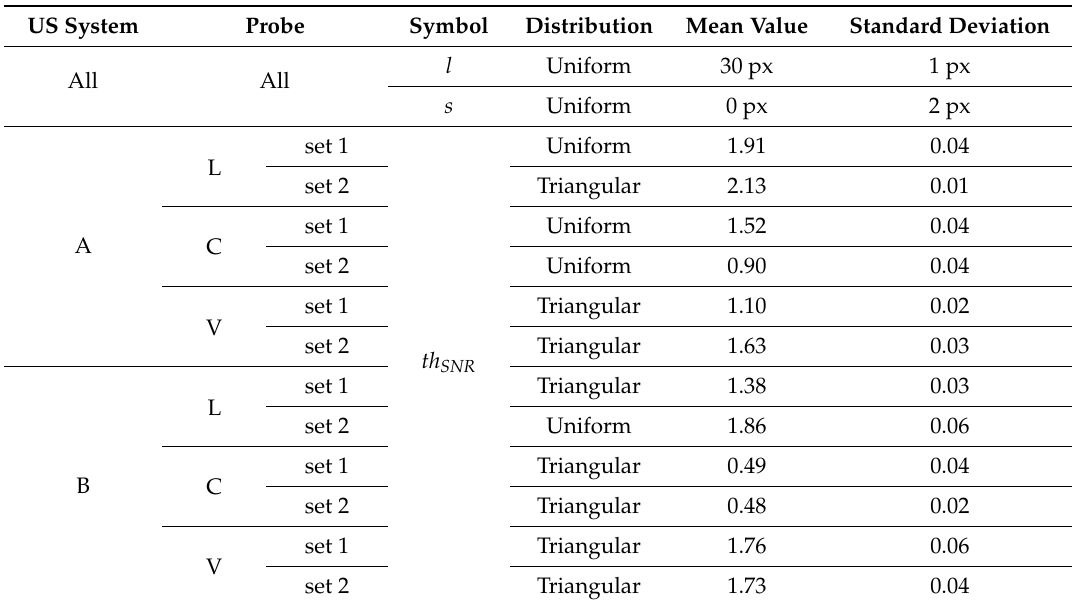
Table3. ( a )VariablesettingsinMonteCarlo s imulations(MCSs)formeasurementuncertaintyestimation of the AdSTM outcomes for A and B US systems. ( b ) Variable settings in MCSs for measurement uncertainty estimation of the AdSTM outcomes for C and D US